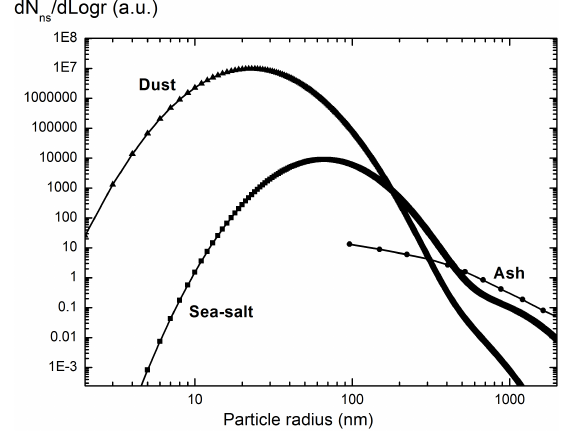
Fig. 3. Selected ns-particle size distributions (PSD) as introduced in numerical calculations for volcanic ash (Mu˜noz et al., 2004), desert dust (Mallet et al., 2004) and sea-salt particles (ss, O’Dowd et al.,